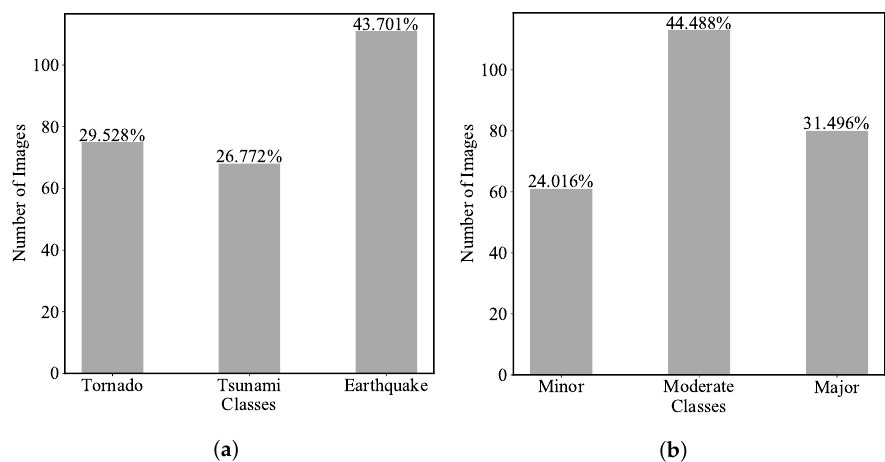
Figure 3. Distribution of class instances: ( a ) Hazard-type; ( b )